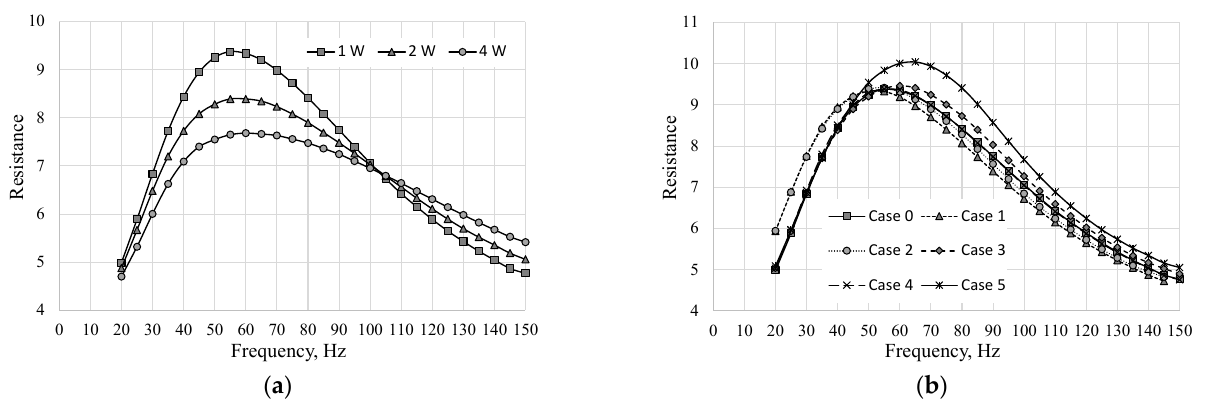
Figure 2. Resistance vs. frequency: ( a ) Case 0 at the different real power; ( b ) different cases at the real power 𝑃 (cid:3404) 1 W.